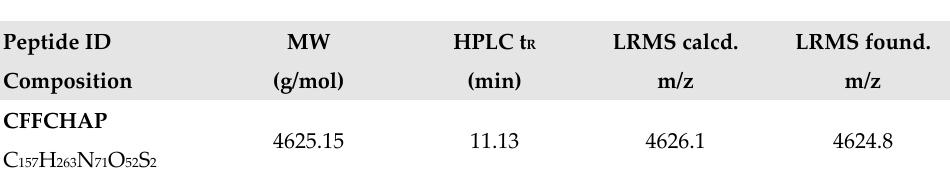
Table 3. Autoantibody status in RA patients (ILD vs. non-ILD).